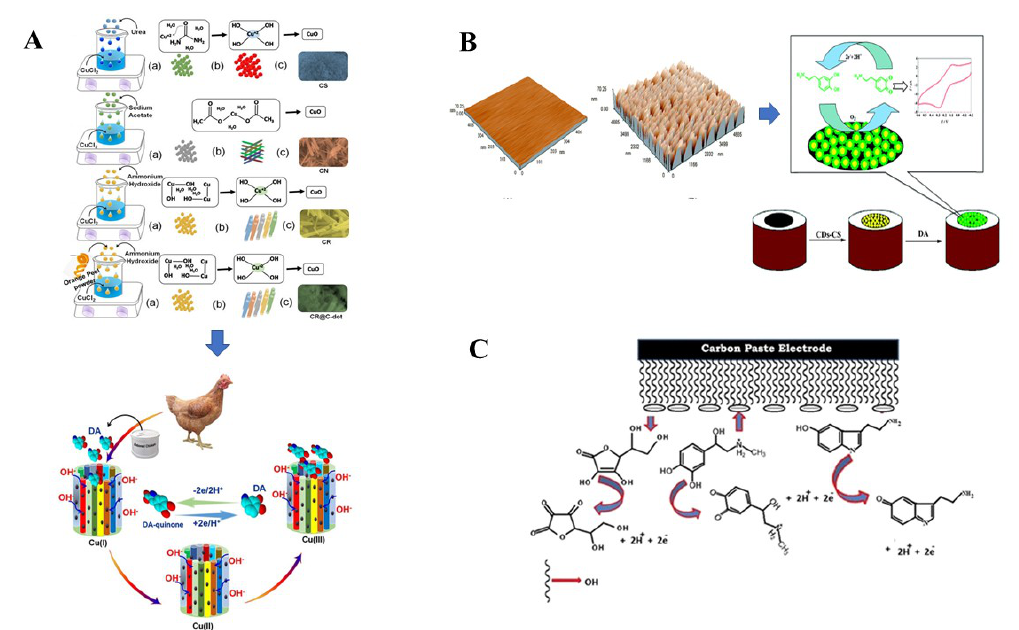
Figure 5. ( A ) Orange Peel Derived C-dots Decorated CuO Nanorods for the Selective Monitoring of Dopamine from Deboned Chicken (Reproduced with permission from ref. [105]. ( B ) Carbon dots and chitosan composite film based biosensor for the sensitive and selective determination of dopamine (Reproduced with permission from ref. [103] ( C ), Carbon Quantum Dot-Modified Carbon Paste Electrode-Based Sensor for Selective and Sensitive Determination of Adrenaline (Reproduced with permission from ref. [107]).